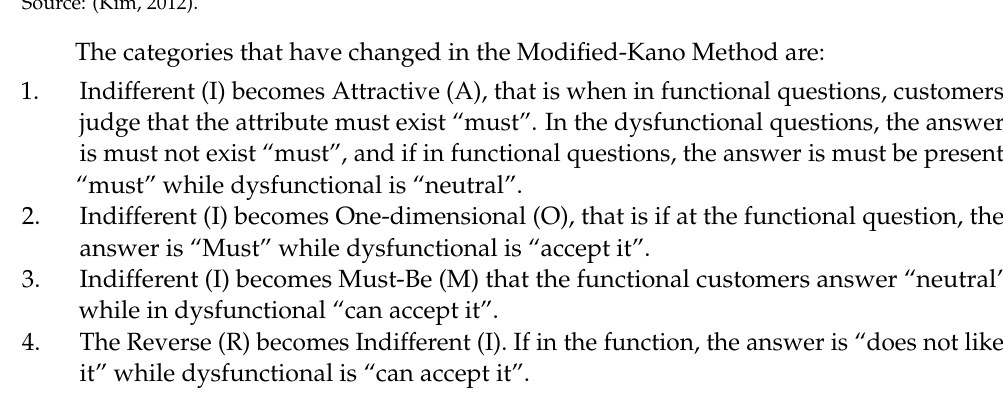
Table 3. Evaluation of Modified-Kano model.